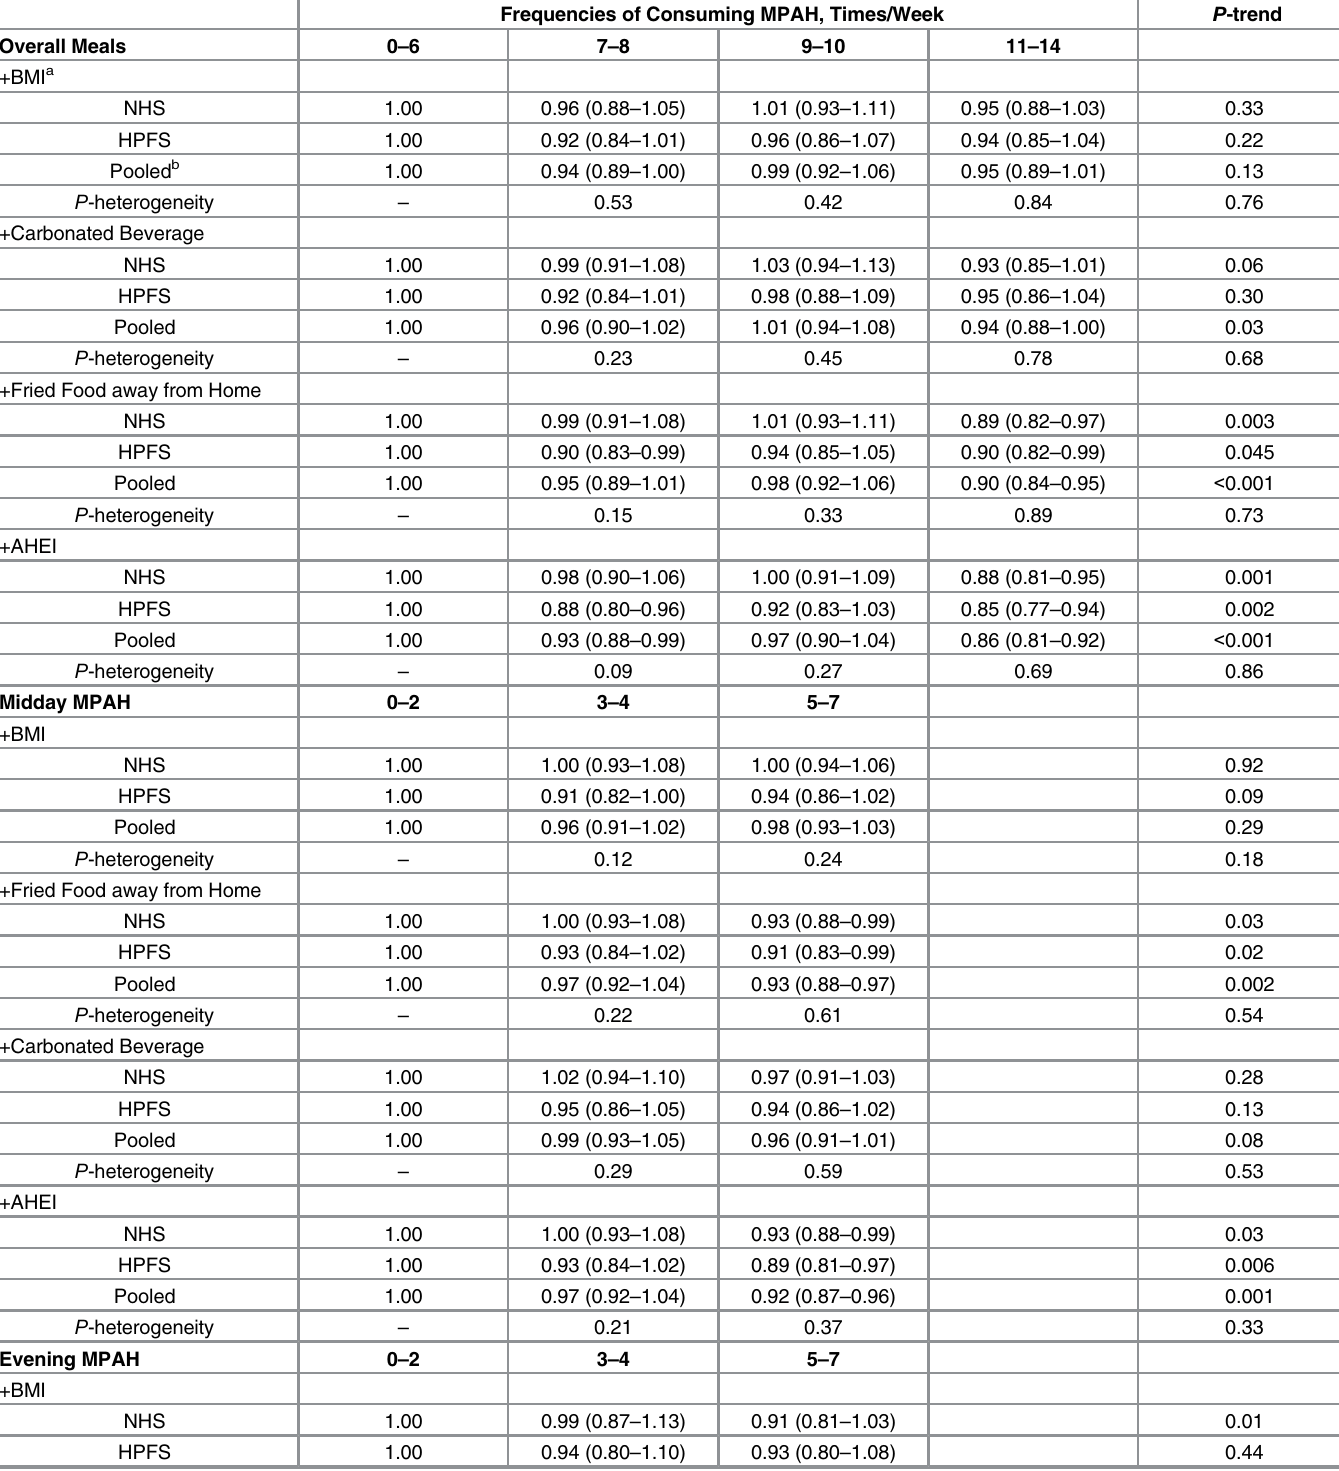
Table 4. Hazard ratios (95% confidence intervals) of type 2 diabetes according to frequencies of consuming meals prepared at home by further adjusting for BMI and dietary